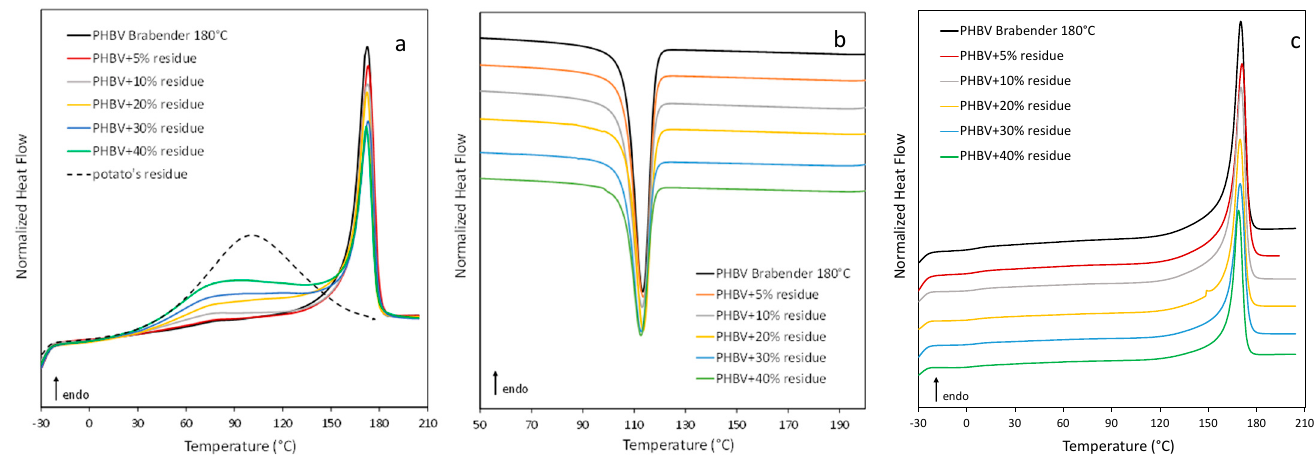
Figure 8. DSC curves of PHBV processed at 180 °C and relative composites ( a ) first scan, ( b ) cooling scan, ( c ) second scan. Table 4. Chemical and thermal characterization of composites prepared by melt mixing at 180 °C. Residue